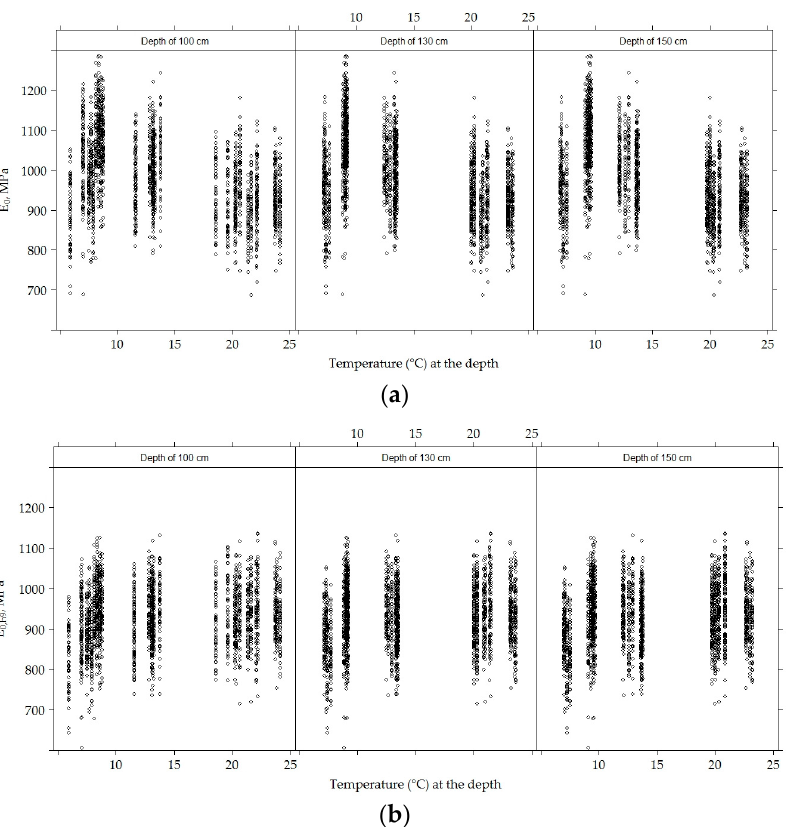
Figure 25. Scatter plots for E 0 ( a ) and E 0,h9 ( b ) values and temperature content at a given